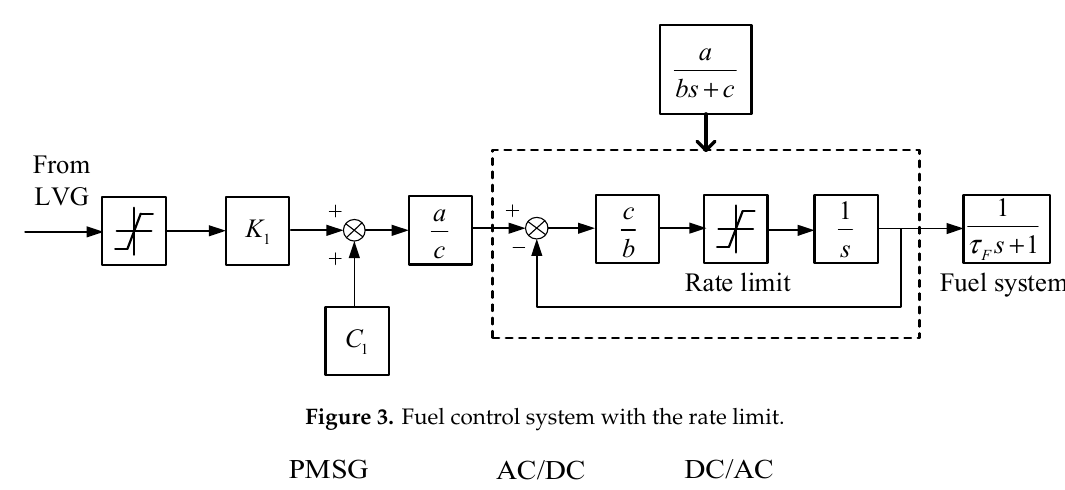
Figure 3. Fuel control system with the rate limit.